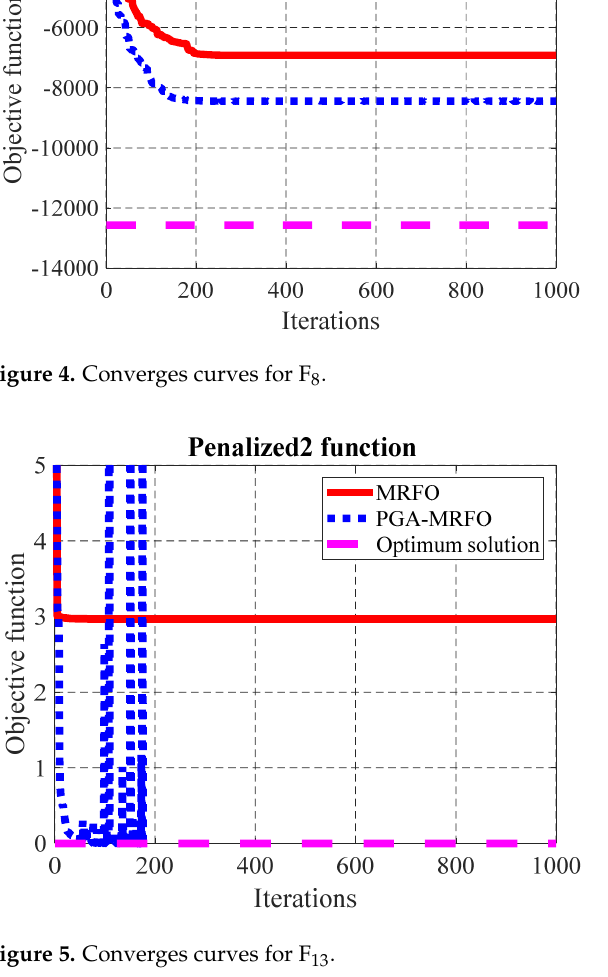
Figure 3. Converges curves for F 7 .